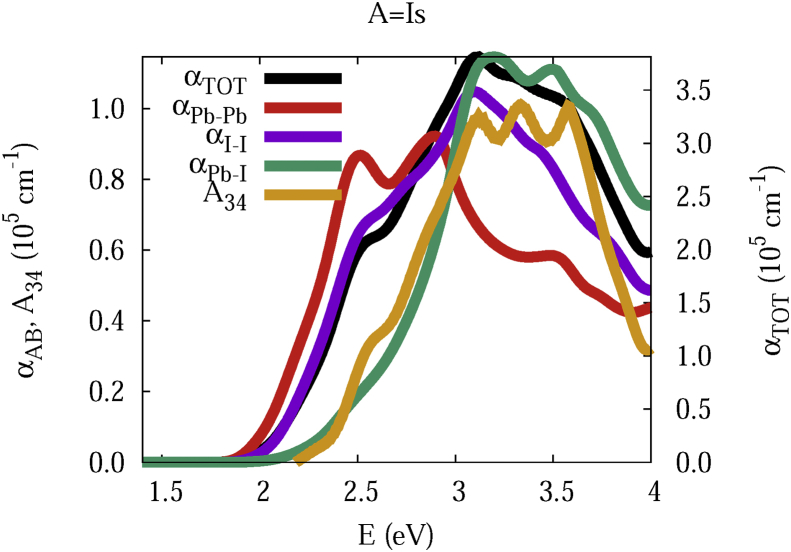
Same legend as that in Fig. 1, but for A = Is.